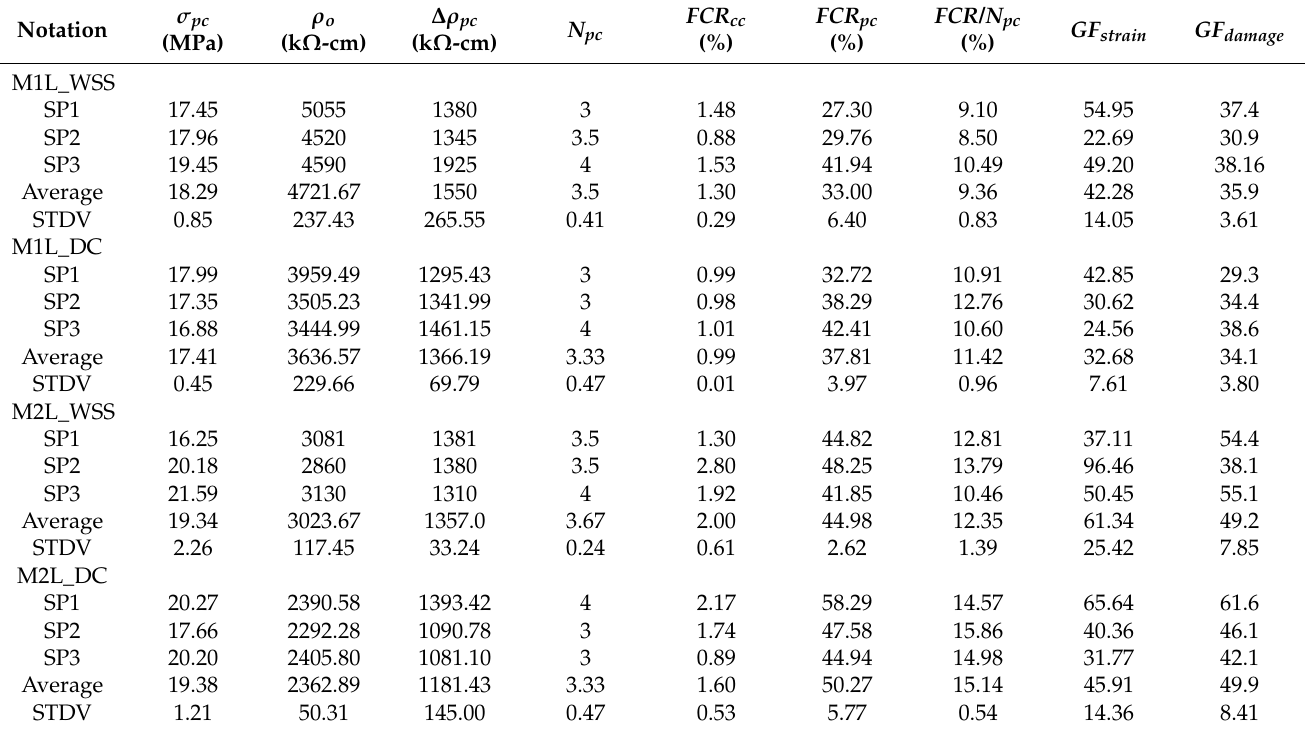
Table 5. Tensile resistivity test